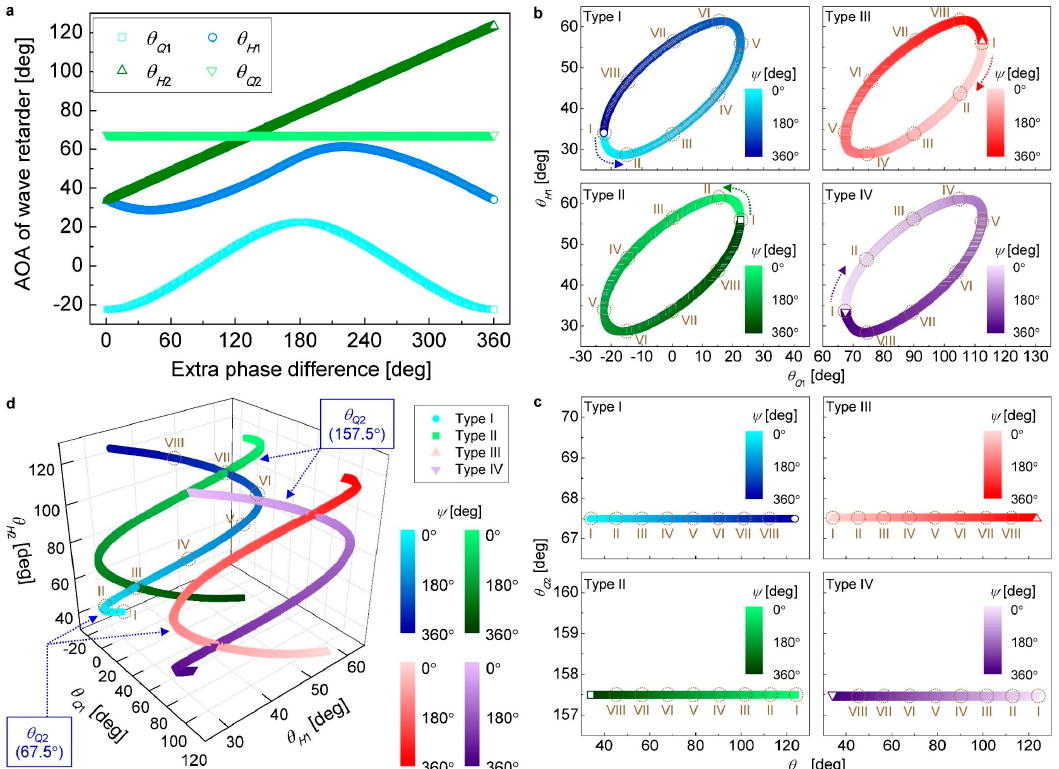
Figure 2. ( a ) Azimuth orientation angle (AOA) sets of four wave retarders ( θ Q 1 , θ H 1 , θ H 2 , θ Q 2 ), indicated by skyblue squares, blue circles, olive triangles, and green inverted triangles, respectively, for the extra phase difference ψ (from 0° to 360° with a step of 1°), which are found for the continuous wavelength tuning of t narrow at θ B 1 = 0°. Four types of loci of ( b ) ( θ Q 1 , θ H 1 ) and ( c ) ( θ H 2 , θ Q 2 ), which are plotted for ψ (from 0° to 360 ° ) at θ B 1 = 0 ° in the Cartesian coordinate systems of ( θ Q 1 , θ H 1 ) and ( θ H 2 , θ Q 2 ), respectively, and ( d ) four types of loci of ( θ Q 1 , θ H 1 , θ H 2 ), which are plotted for ψ (from 0° to 360 ° ) at θ B 1 = 0 ° in the Cartesian coordinate system of ( θ Q 1 , θ H 1 , θ H 2 ).